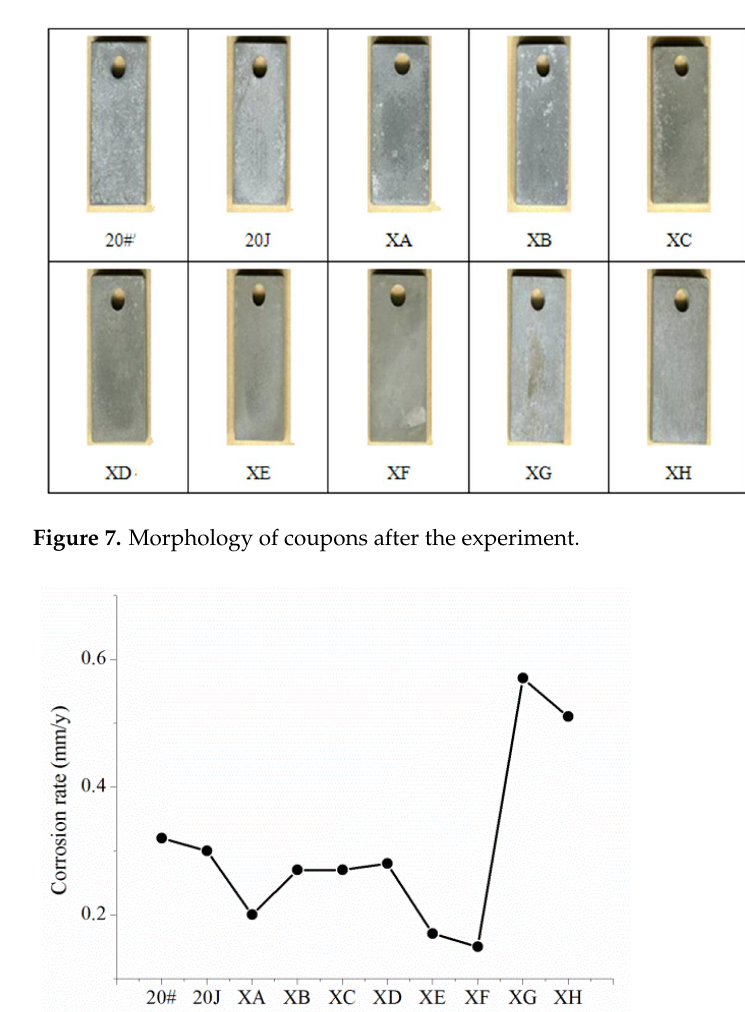
Figure 7. Morphology of coupons after the experiment.